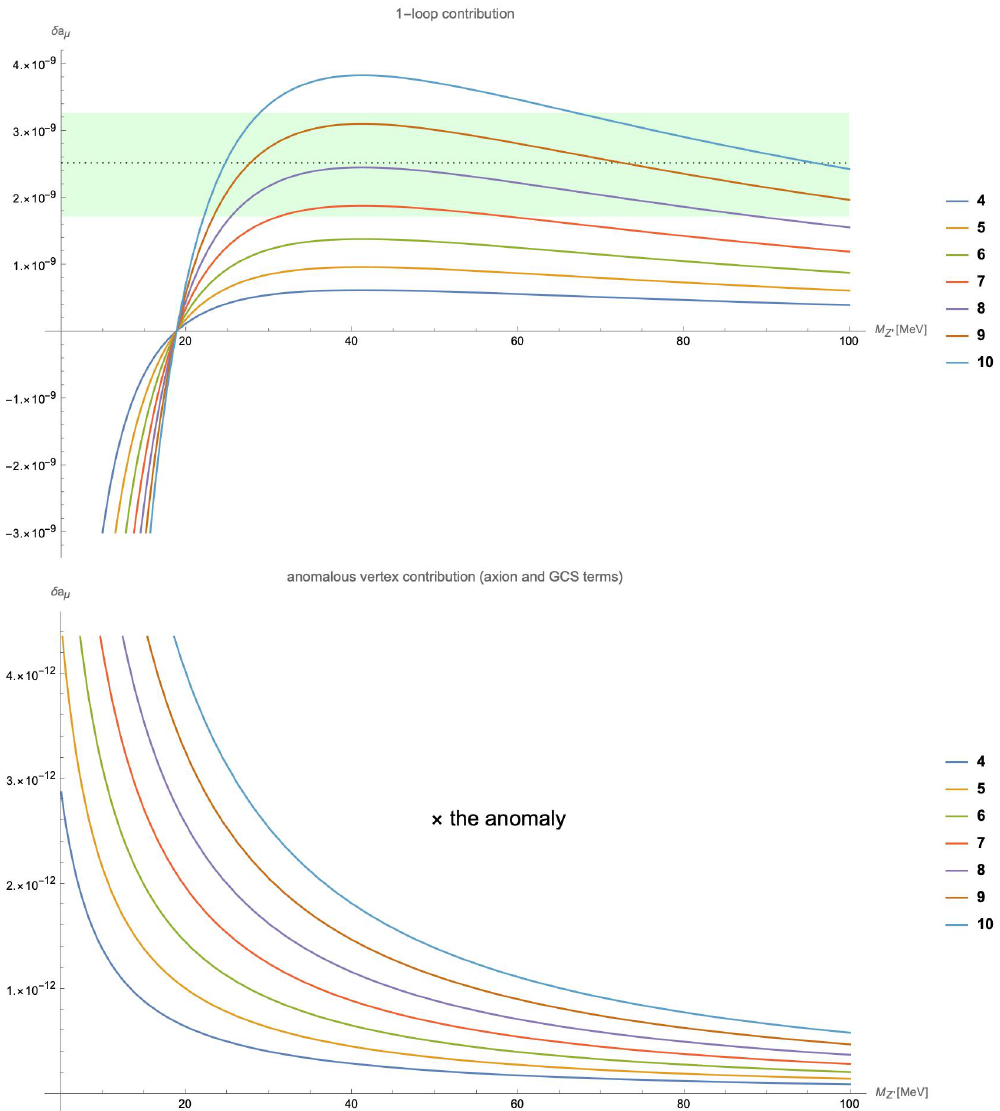
Figure 2 . The two plots give the contribution to the g − 2 from the one-loop and the two-loop µ − Z 0 µ − Z 0 (anomalous) amplitudes, for different g = 10 × g = (4 − 10) × 10 − 4 , represented by dif- Z 0 q Z 0 q V A ferent colored lines. In the first plot, the dashed line is the δa (1.3) and the green zone the 1 σ √ uncertainty ( δσ = 63 2 +43 2 × 10 − 11 ). Notice that the contribution from Z 0 with masses below the 20 MeV becomes negative. In the second diagram, we present the contribution of the anomalous diagram without the overall anomalous factor t . For an anomaly equal to 100, this contribution ijk is within the experimental error and for even larger anomaly values becomes